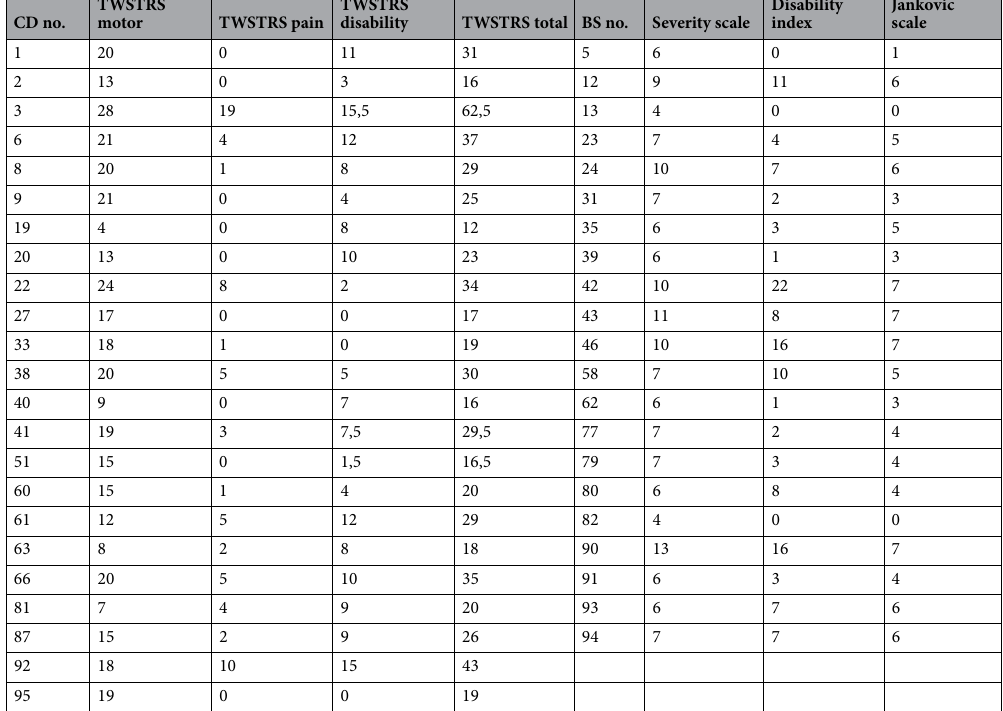
Table 4. Clinical assessment of cervical dystonia and blepharospasm patients. CD: cervical dystonia, No.: number, TWSTRS: Toronto Western Spasmodic Torticollis Rating Scale, BS: blepharospasm.